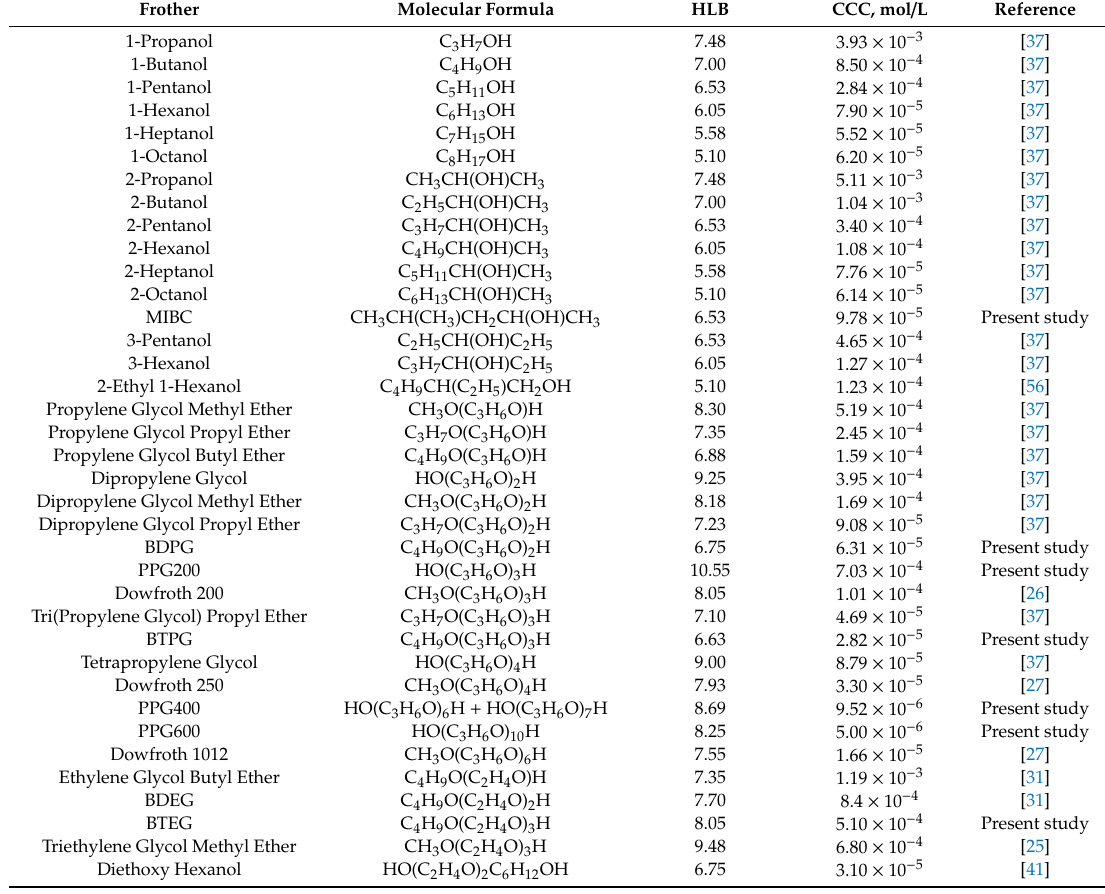
Table 1. Frothers, molecular formula, hydrophilic-lipophilic balance (HLB), critical coalescence concentration (CCC), and